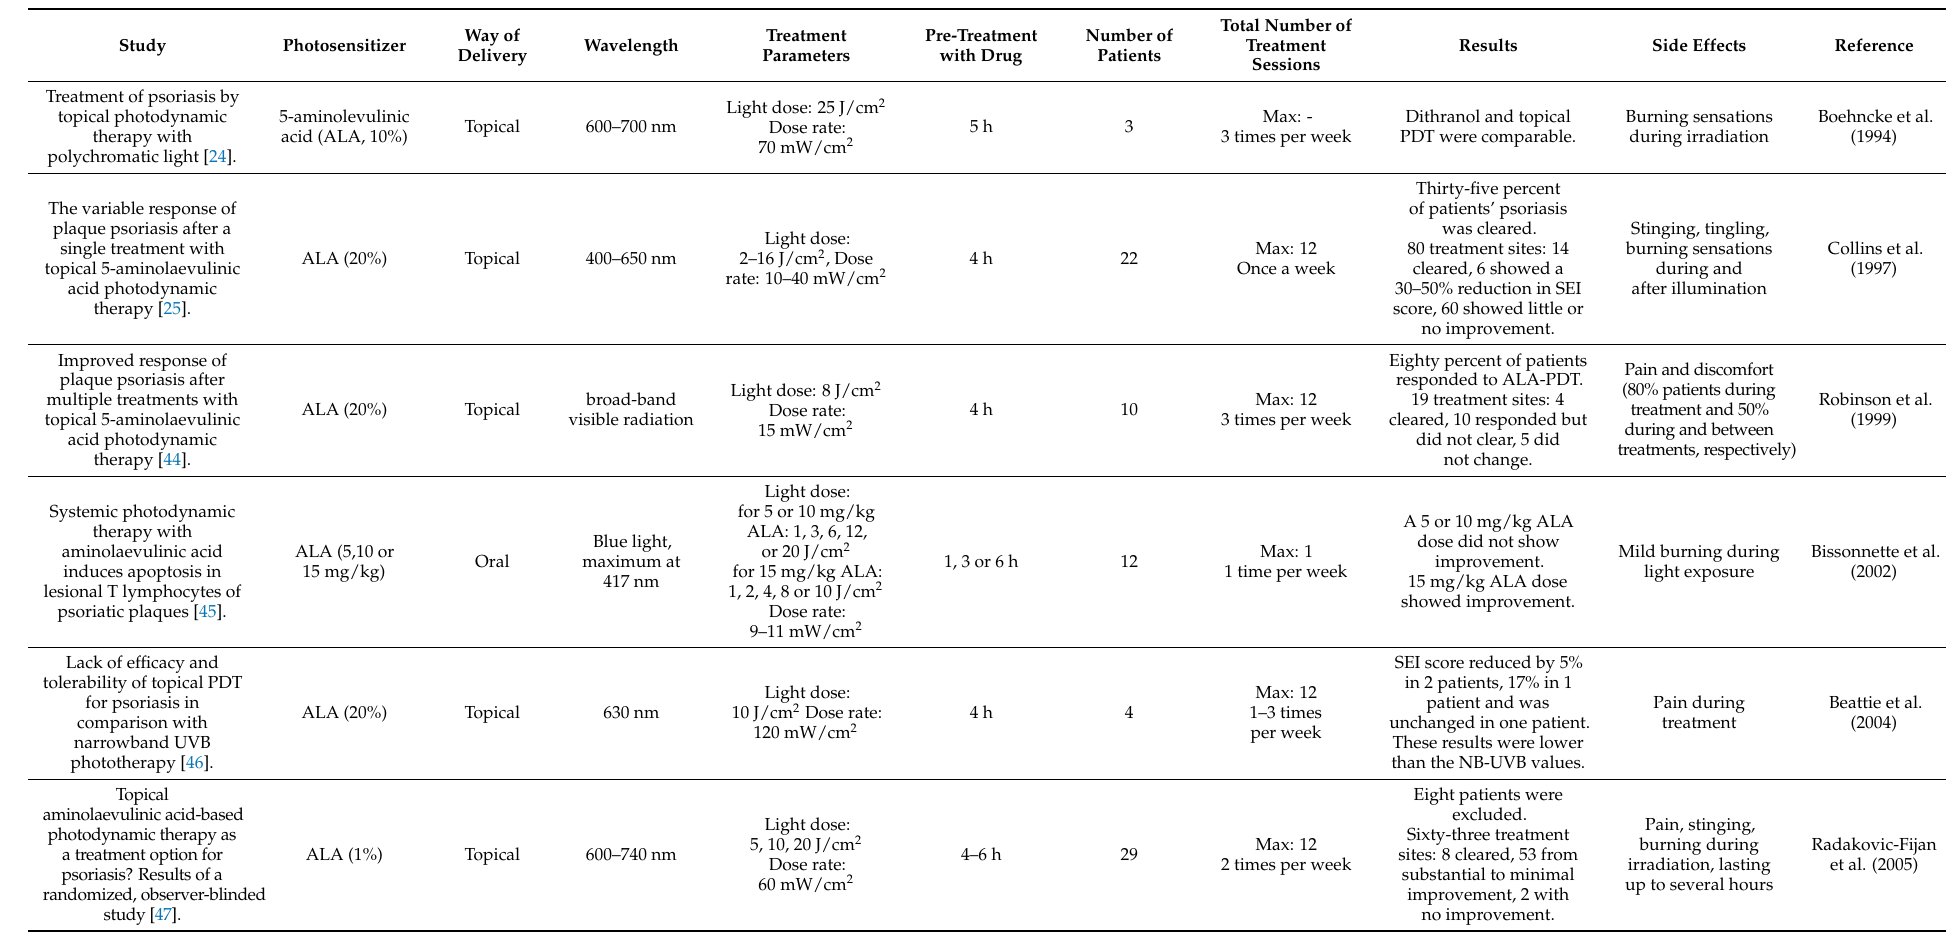
Table 1. A summary of in vivo studies and clinical trials evaluating the effect of PDT in psoriasis